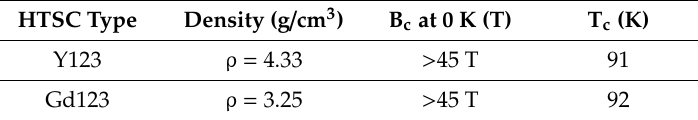
Table 4. Parameters of the HTSC-materials [28,29].